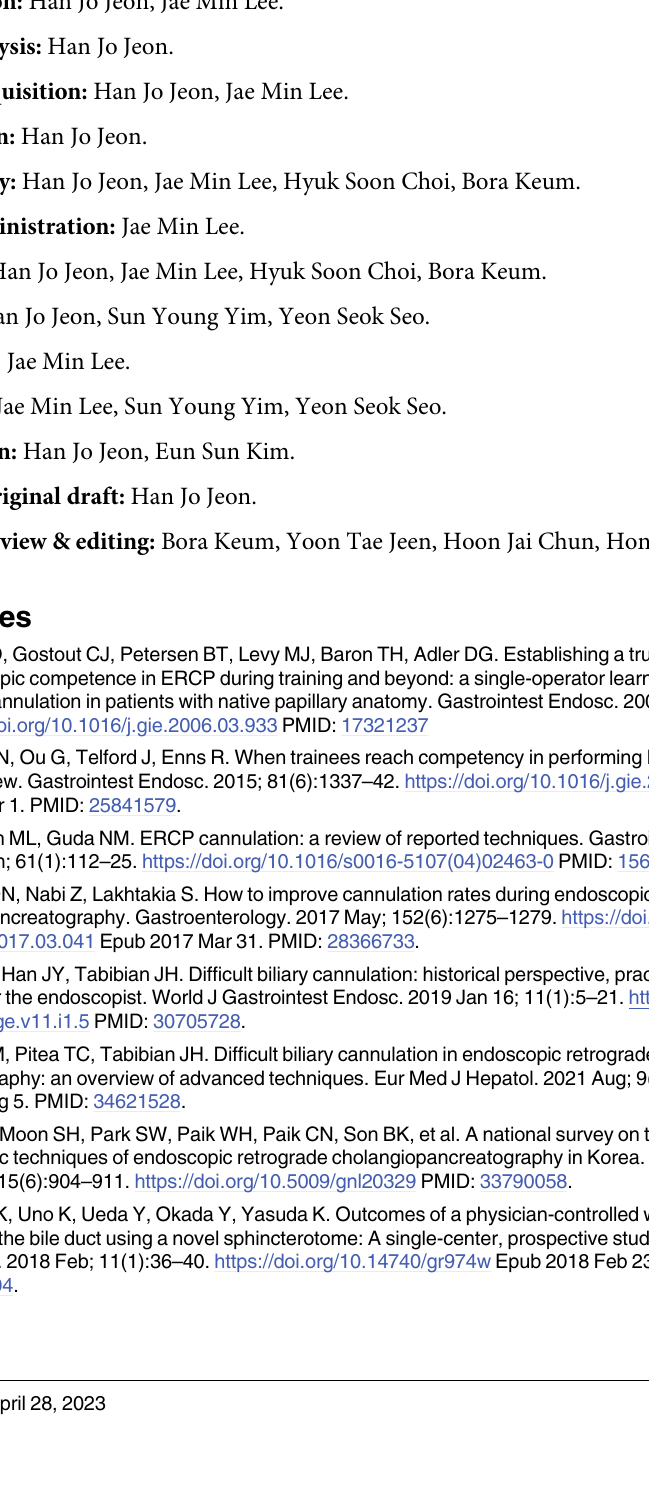
S1 Table. Comparison of primary clinical outcomes before propensity score matching cohort between easy and difficult groups based on